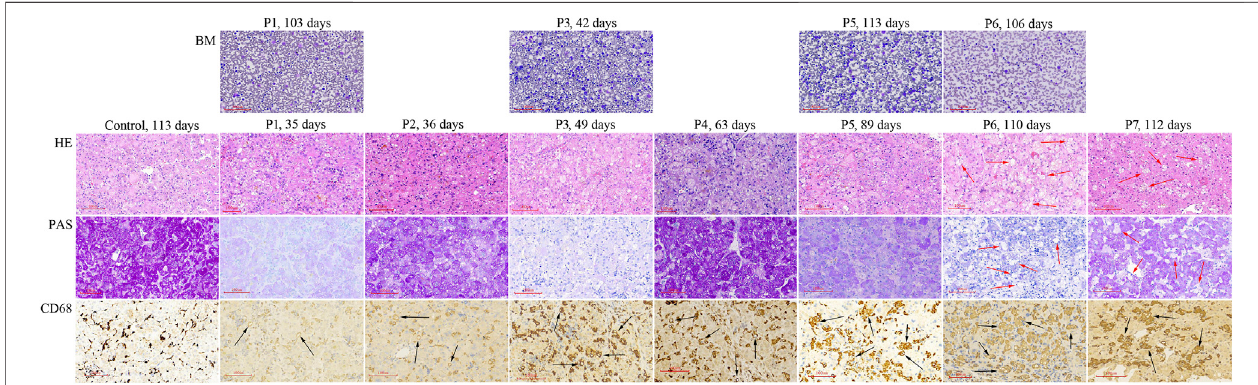
FIGURE 1 | Histologic studies of bone marrow aspirations and liver tissues obtained from NP-C patients presenting as neonatal cholestasis. Vacuolated Kupffer cells (black arrow) are observed in CD68 staining sections from liver tissues of all 7 NP-C infants (P1 ~ P7), but not in control (a neonatal cholestatic infant with